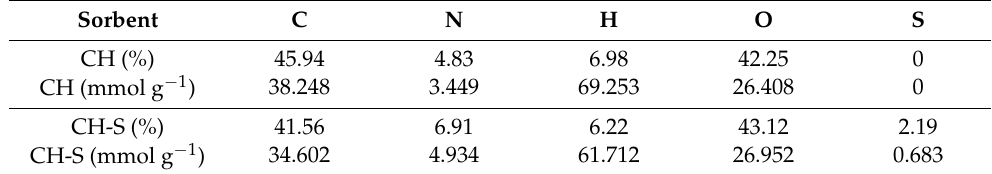
Table 3. Elemental analysis of CH and CH-S sorbents.